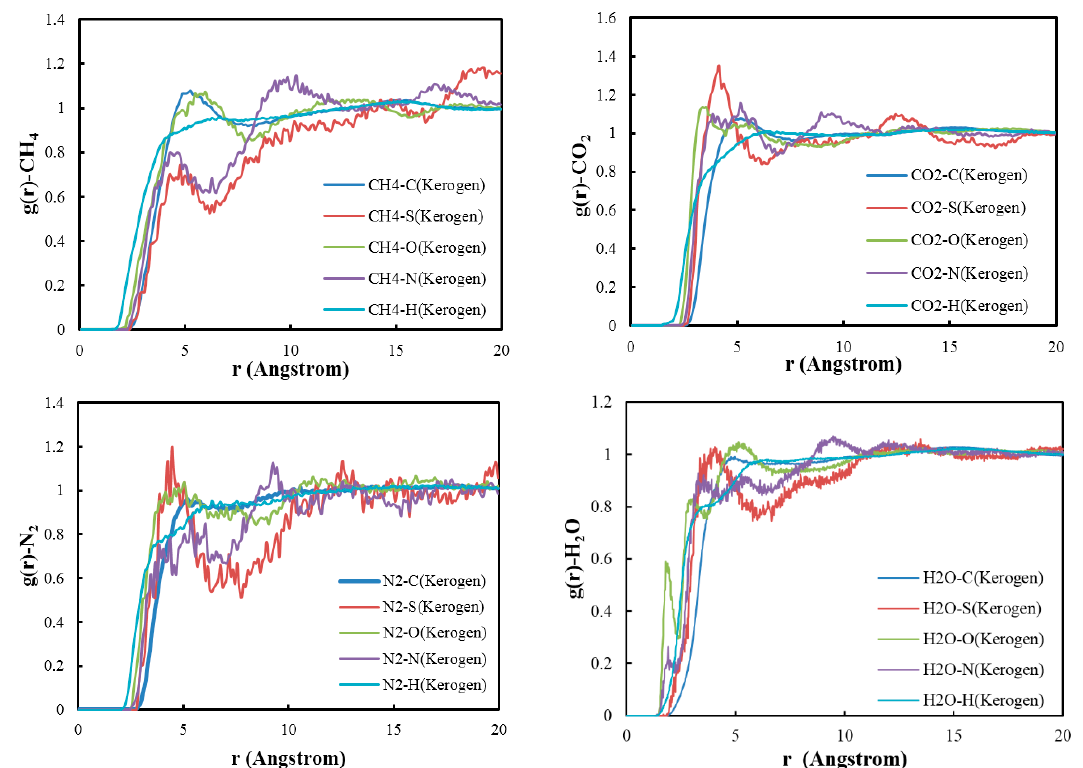
Figure 7. The RDF of CH 4 , CO 2 , N 2 , H 2 O and the atoms (C, H, O, N, S) in Kerogen.